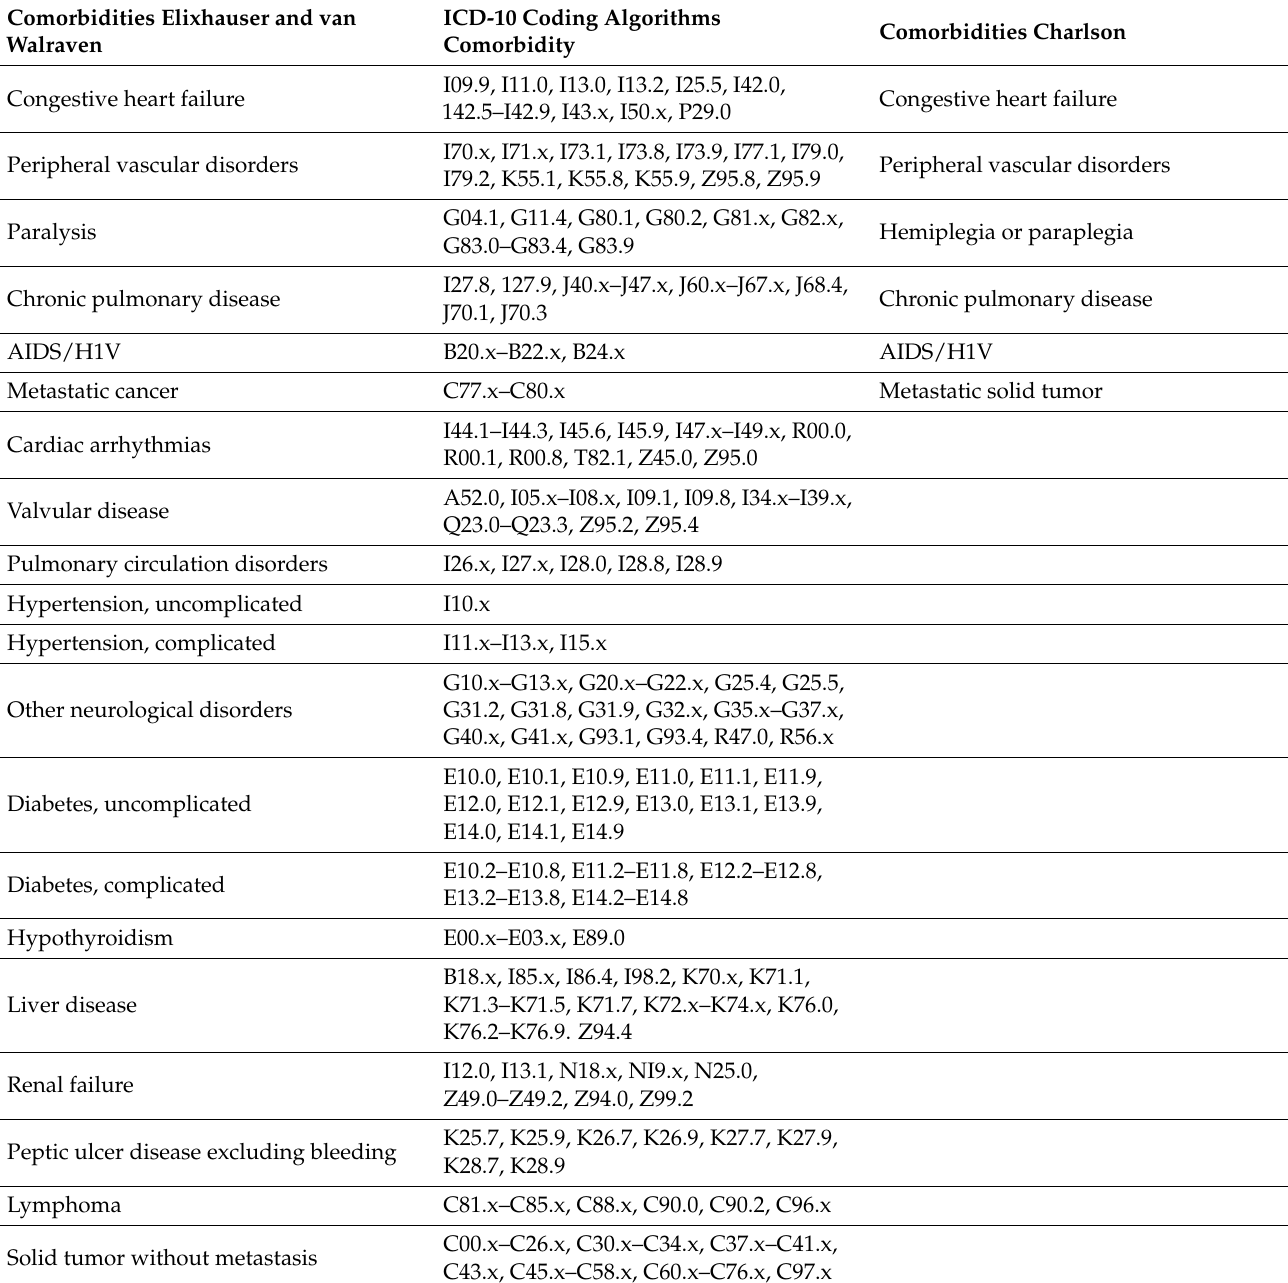
Table A1. Comparison of ICD-10 coding algorithms for Elixhauser/van Walraven and Charlson